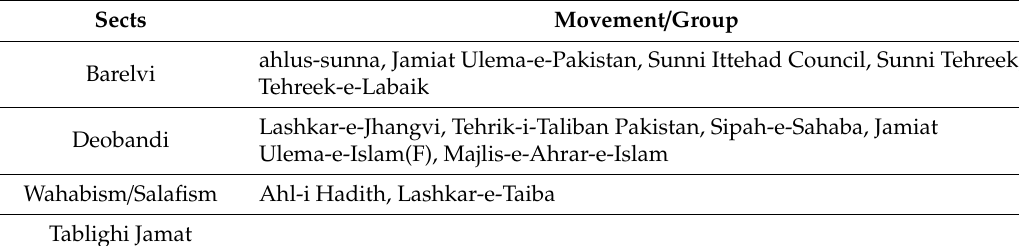
Table 2. Di ff erent sects and their associated movement groups within Sunni Muslims in Pakistan.